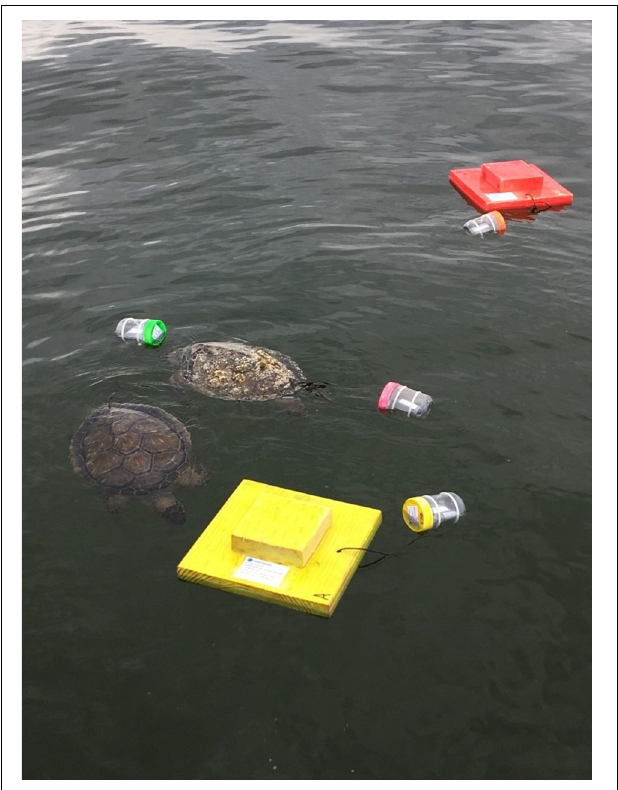
FIGURE 1 | Sea turtle carcasses, wood effigies and satellite tags at deployment